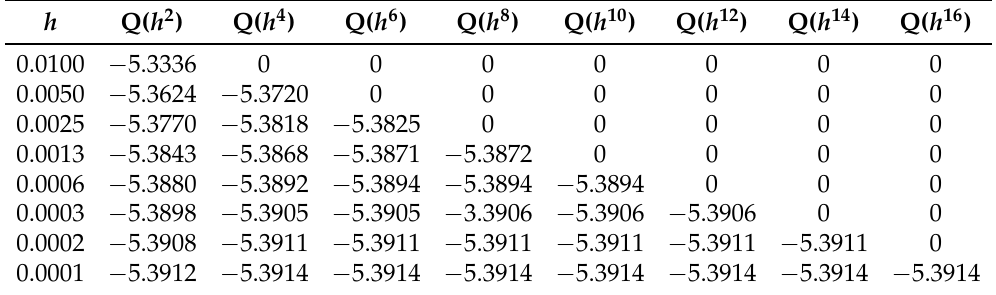
Table 5. The numerical result when α = 1 using modified central formula with Richardson